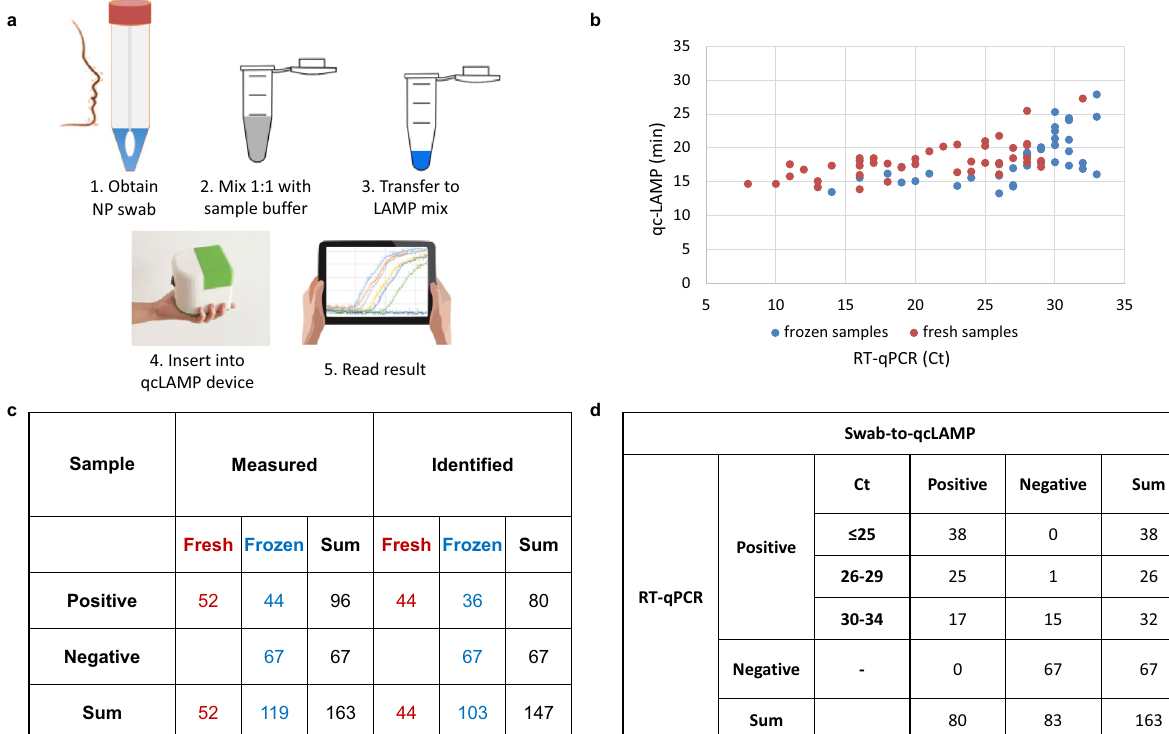
Figure 5. ( a ) Schematic representation of the workflow of the SARS-CoV-2 swab-to-qcLAMP detection, i.e. without RNA purification. ( b ) Scattered plot of the Ct values of PCR-confirmed positive samples by using the HNB colorimetric dye inside the LAMP-mix. ( c ) Table presenting overall diagnostic sensitivity and specificity of the qcLAMP for fresh and frozen samples; the red and blue colors are used to guide the eye and depict fresh and frozen samples, respectively. ( d ) when considering various Ct cut off values. For Ct < 30 sensitivity becomes 98% (95% CI: 95–101) and negative likelihood ratio 0.016 (95% CI: 0.002–0.109); for Ct < 25, sensitivity is calculated to be